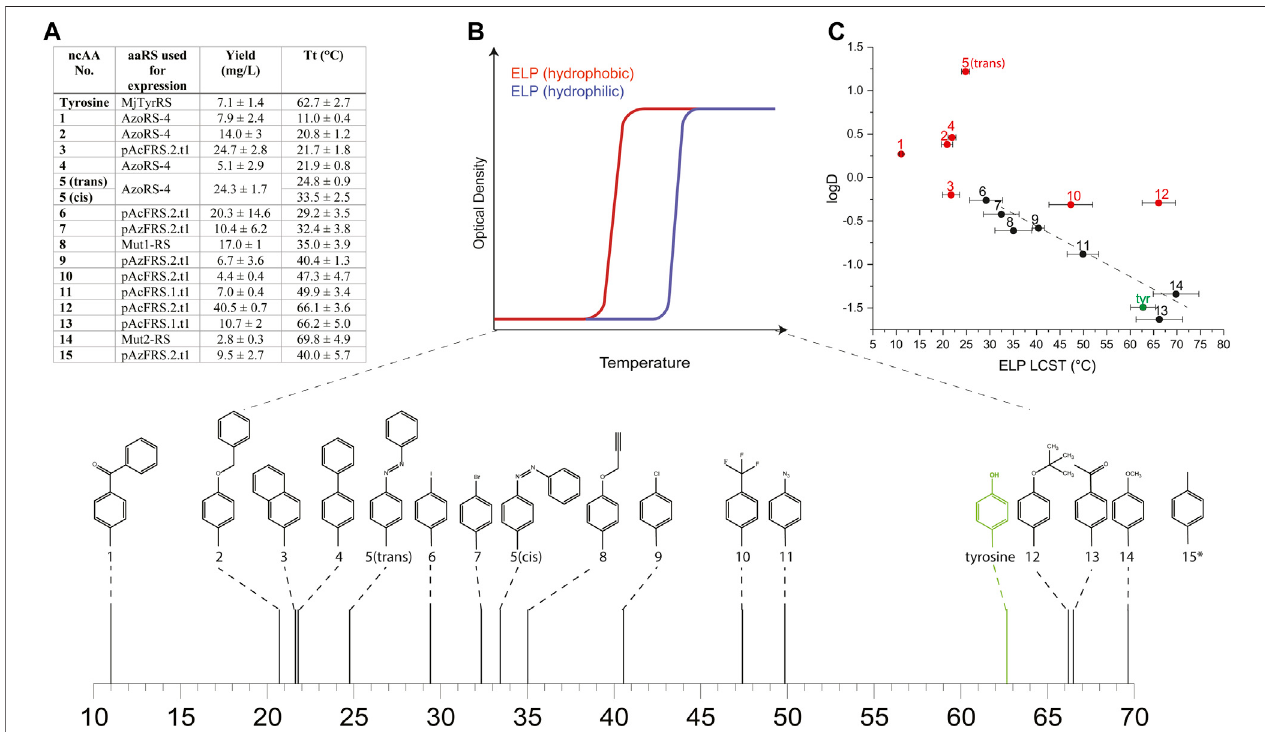
FIGURE 2 | (A) Yields and LCST values calculated for ELPs containing each of the 15 ncAAs depicted in Supplementary Figure S1 and expressed using the indicated aaRS. (B) A schematic illustration of the effect of the relative hydrophobicity of the AA or ncAA incorporated into the ELP sequence on its LCST, and the measured LCST values for ELPs bearing ncAAs 1 – 14 (*the LCST of ELP 60 (15 × 10) was too high to be measured in ddH 2 O, and was therefore determined in ddH 2 O supplementedwith1MNaCl). (C) TherelationshipbetweentheLCSTofELPsbearingncAAs1 – 14andthepredictedlogDvaluesofthencAAs.Redandblackdata points indicate ELPs that were found to self-assemble or that remained as monomers,